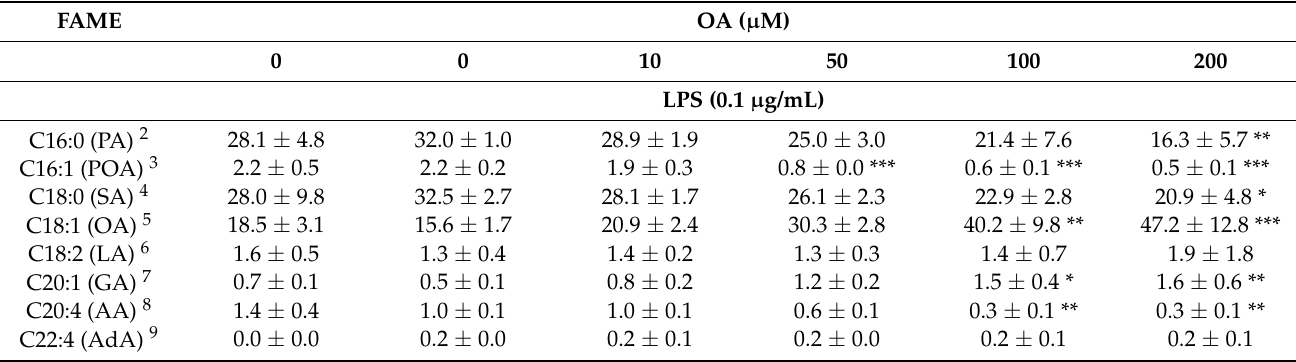
Figure 4. Effects of fatty acids (FA) and olive oil extracts (OOE) on the LPS-induced formation of prostaglandin E 2 (PGE 2 ). The release of PGE 2 in LPS-stimulated RAW264.7 macrophages was increased by OOE and FAs. Cells were pre-incubated with serum-free medium, OOE, oleic acid (OA), linoleic acid (LA), palmitic acid (PA), or of a defined FA mixture (Mix) of the mentioned FAs (80:10:10) for 4 h followed by a co-incubation with 100 ng/mL LPS for an additional 20 h ( A ). Cells were pre-incubated with serum-free medium or 1–200 µM OA for 4 h followed by a co-incubation with 100 ng/mL LPS for an additional 20 h ( B ). Untreated control samples were cultured with serum-free medium for 4 h plus another 20 h; values of positive controls (LPS) were defined as 100%. Data are shown as mean formation levels ± standard deviation of four ( A ) or three ( B ) independent biological replicates. Significant differences compared to the untreated control °°°° p < 0.0001), to the LPS control (* p < 0.05) and between samples ( a,b,c, p < 0.05; different small letters represent statistically different values) were obtained by RM one-way ANOVA tests. Table 1. Fatty acid composition (% of total FAME 1 as means ± S.D.) of RAW264.7-cells incubated with 0–200 µ M OA compared to LPS-treated